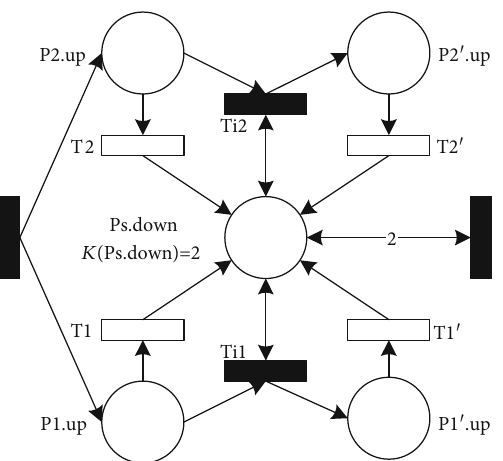
Figure 13: The Petri net-based reliability model of the rudder control